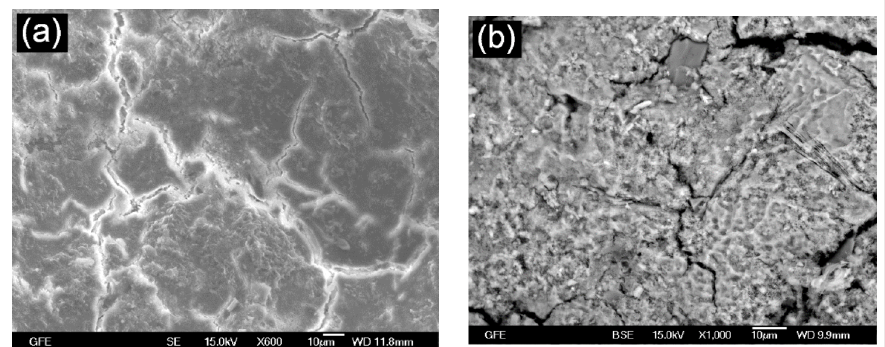
Figure 10. SEM micrographs (1 mm depth) of concrete with ( a ) CEM I 42.5 N and ( b ) CEM I 42.5 N-SR3 (w/c = 0.50) stored for 182 d at 5 ◦ C in Na 2 SO 4 solution with 6000 mg SO 42 − /L.